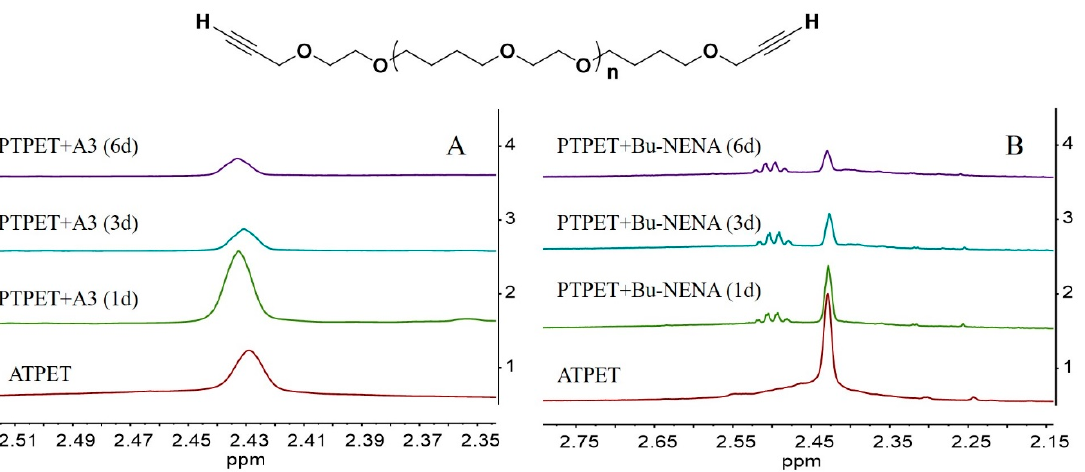
Figure 2. Temporal evolution of the 1 H-NMR spectra of the PTPET + A3 ( A ) and PTPET + Bu-NENA ( B ) systems.